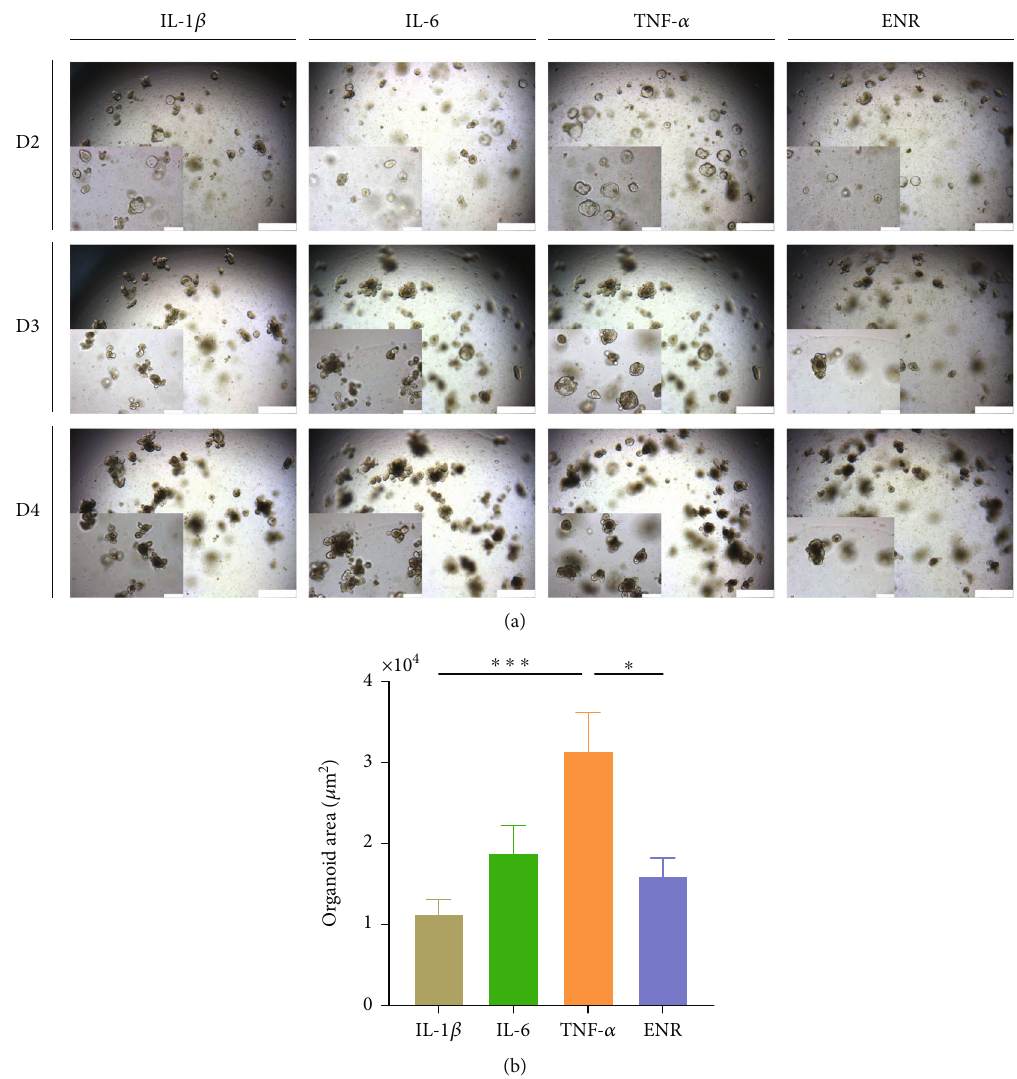
Figure 5: Intestinal organoids with di ff erent proin fl ammatory cytokine treatments. (a) Images of intestinal organoids with di ff erent proin fl ammatory cytokine treatments. IL-1 β ( fi rst column), IL-6 (second column), TNF- α (dose: 10ng/mL; third column), and untreated control (ENR, fourth column). Images were taken continuously for 4 days of culture: day 2 ( fi rst row), day 3 (second row), and day 4 (third row). Scale bars = 500 μ m. Bottom left corners displayed a zoomed-in intestinal organoids from each image. Scale bars = 200 μ m. (b) The organoid area with di ff erent proin fl ammatory cytokine treatments. P values were determined by one-way ANOVA. ∗ P < 0 : 05 ; ∗∗ P < 0 : 01 ; ∗∗∗ P < 0 : 001 . The experiments were independently repeated at least three times with similar results. ENR: EGF/Noggin/R-Spondin